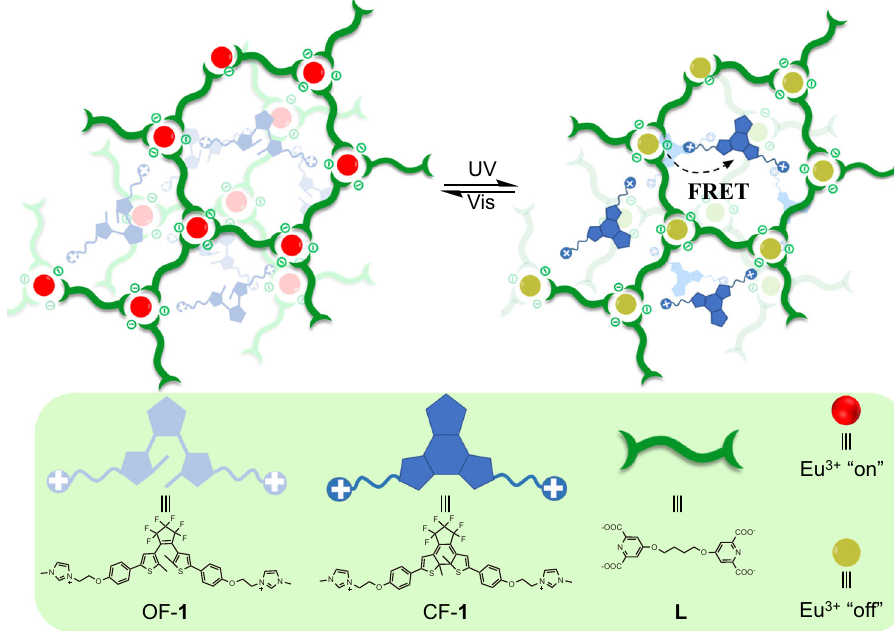
Fig. 1 Schematic illustration. The construction of the photochromic supramolecular coordination polyelectrolyte, and the chemical structures of corresponding components.